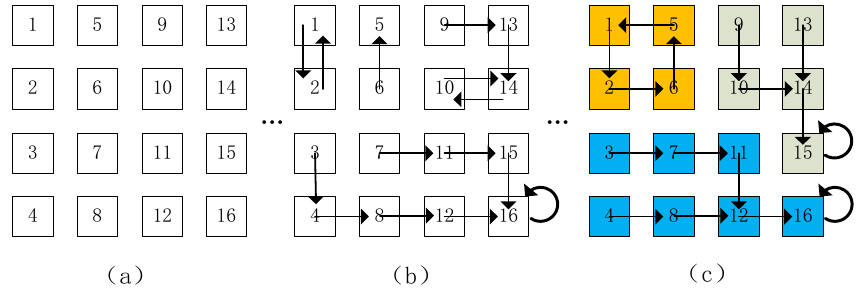
Figure 1. The illustration of distance dependent Chinese restaurant process (ddCRP) for image over-segmentation; ( a ) an image (i.e., a restaurant) with 16 pixels (i.e., customers) where each numbered square denotes a pixel; ( b ) each arrow indicates a customer choose to sit with another customer; and, ( c ) a segment consists of pixels with a same color and every two pixels within a segment can reach to each other along the inferred customer assignments.